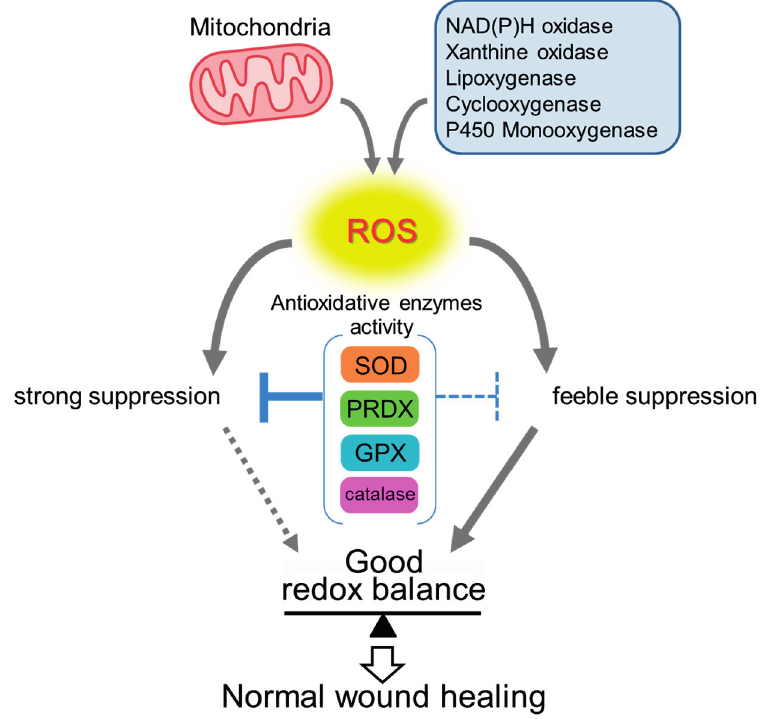
Figure 3. Redox balance maintained by antioxidative enzymes. Since excessive ROS is cytotoxic, redox balance must be strictly controlled in order to achieve normal wound healing. ROS that are generated by several oxidases and mitochondrial respiration must be reduced mainly by antioxidative enzymes such as SOD, PRDX, GPX, and catalase. An optimal ROS level is distinctive in each process of wound healing. Hence, each antioxidative enzyme needs to be enhanced or suppressed, as required, to maintain ROS levels suitable for each process of wound